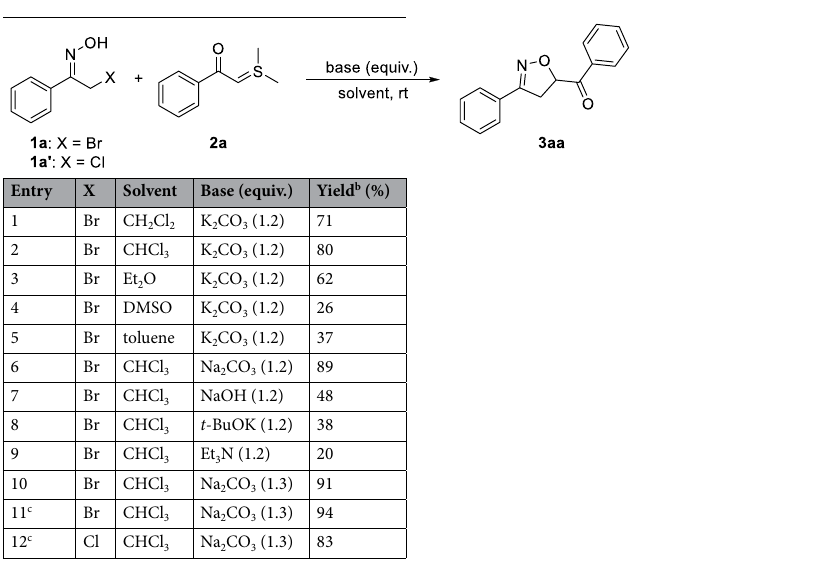
Table 1. Optimization of the reaction conditions a . a Reaction conditions: 1a (0.40 mmol), 2a (0.48 mmol), solvent (4 mL), base. b Yield of isolated product. c The ratio of 1a or 1a ʹ and 2a is 1:1.3. DMSO: dimethyl